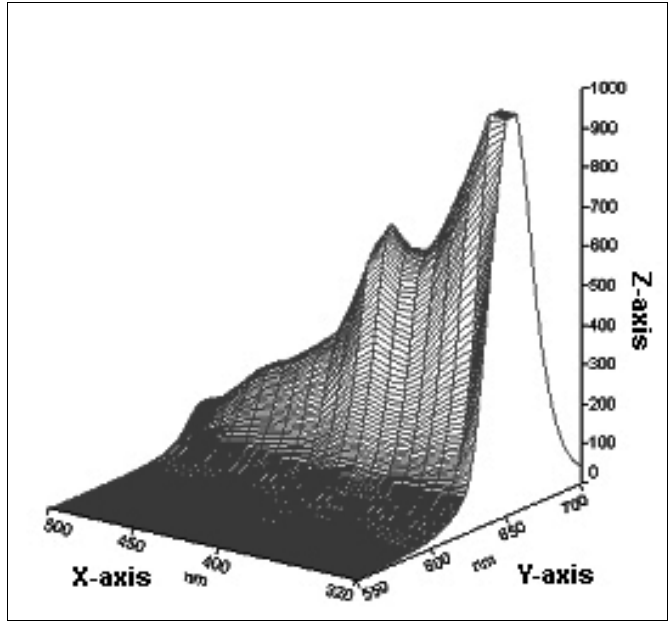
Figure 5. Excitation - emission spectra of red QDs. Z-axis: fluorescence intensity in arbitrary units. X-axis: Excitation wavelengths (nm). Y-axis: Emission wavelengths (nm). The emission peak was observed at 655 nm for all excitation wavelengths